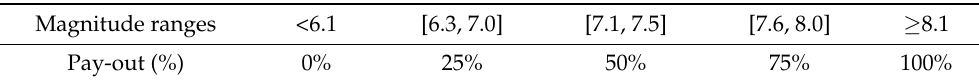
Table 7. Compensation % based on the magnitude trigger